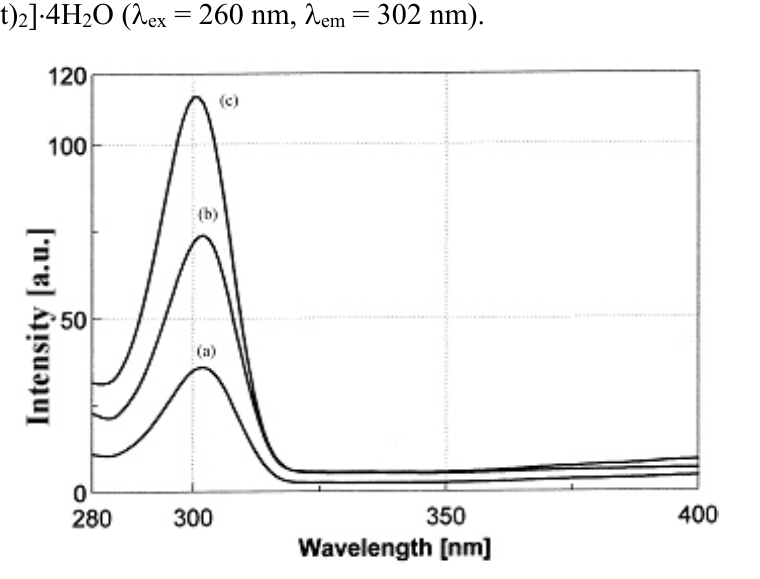
Figure 4. Fluorescence spectra of (a) rutin trihydrate, (b) [VO(rutin)(H